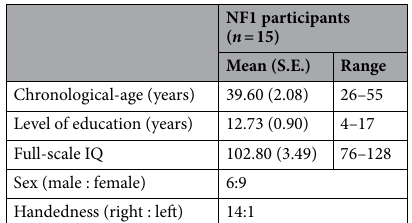
Table 3. Demographic characteristics. NF1 neurofibromatosis type 1, S.E. standard error, IQ intelligence quotient.